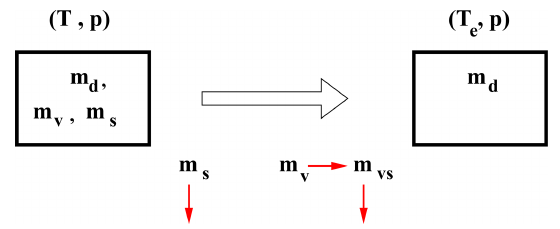
Figure A1. The equivalent potential temperature T e of an air parcel with temperature T and pressure p and with the dry mass m d , water vapor content m v , and the liquid and/or solid water content m s . T e is defined by a reversible process completely removing m v by vapor- water condensation (i.e., transforming pseudoadiabatically m v into m vs ) and by using this energy to heat the original air parcel by p = const, i.e., T e > T . Liquid and/or solid water ( m s ) are removed, but without any correction of T e . (i.e., due to sedimentation this is a pseudoadiabatic and not a pure adiabatic